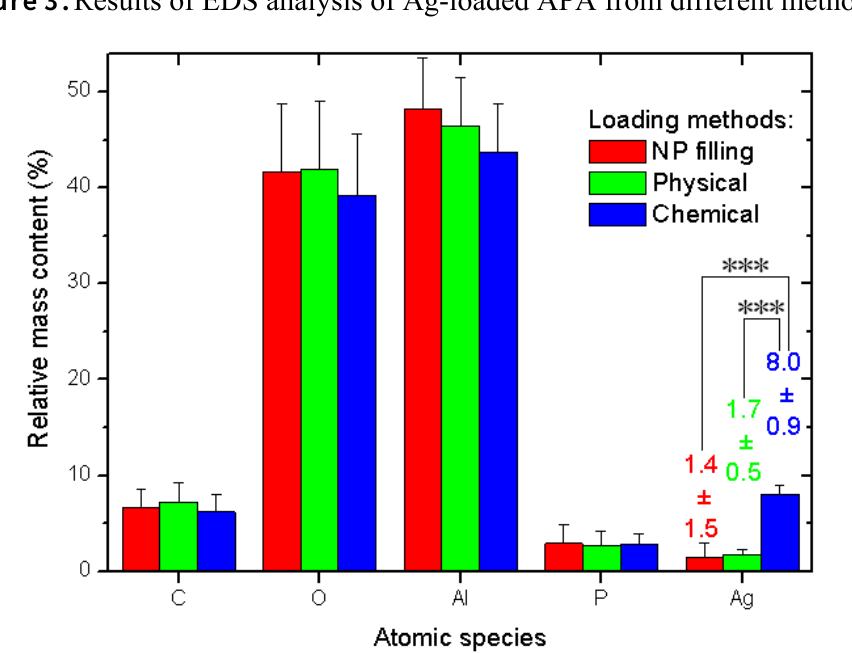
Figure 3. Results of EDS analysis of Ag-loaded APA from different